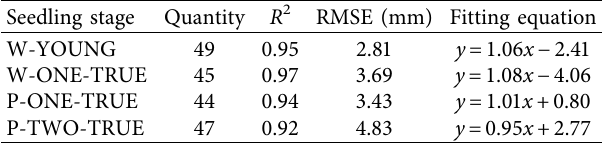
Table 3: Analysis of seedling height calculation results. Seedling